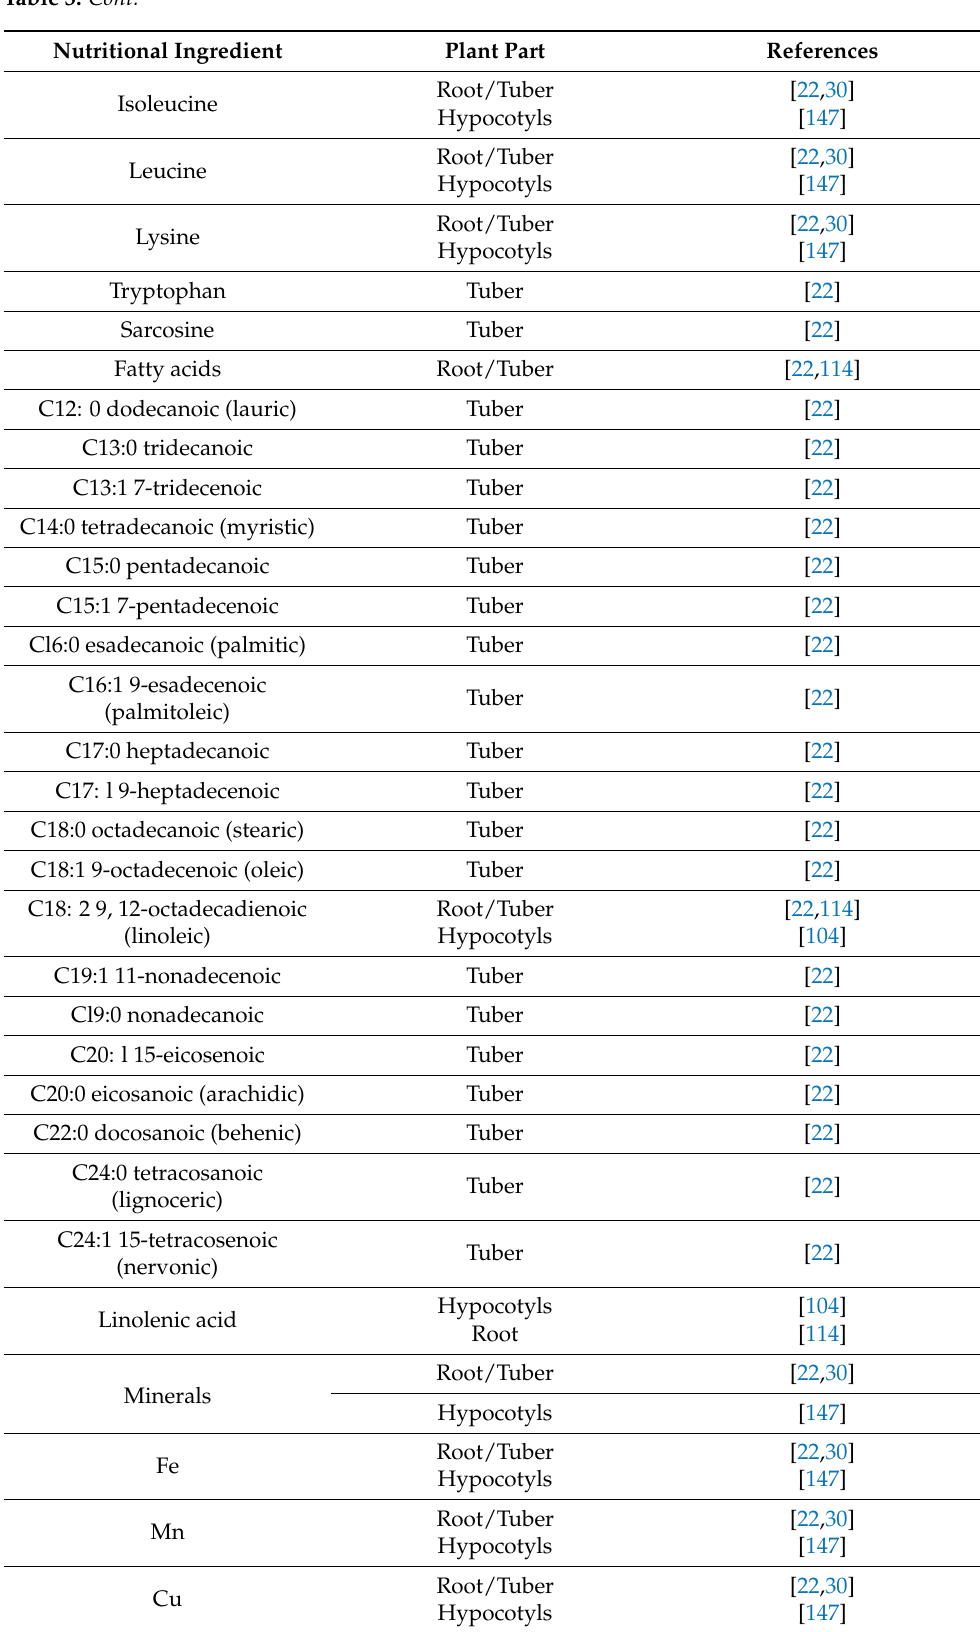
Table 3. Cont. Nutritional